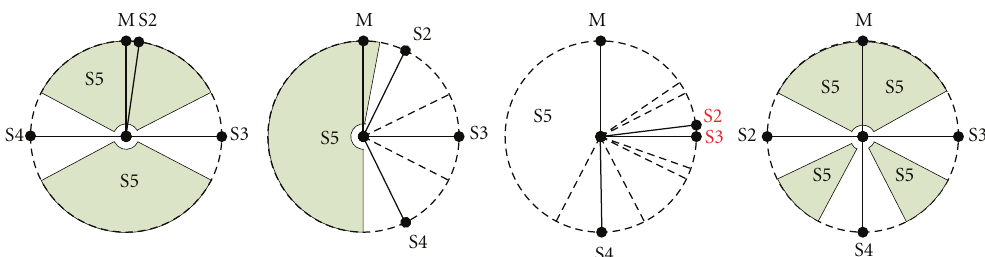
Figure 19: Appropriate constellations of five satellites for the usage of a Master-Slave approach. (M—Master, S2,3,4,5—Slaves, with φ Master = φ slaves ). The coloured fields indicate appropriate positions of S5. In the third case there is an inappropriate constellation for Master-Slave, since S2 and S3 are highly correlated.